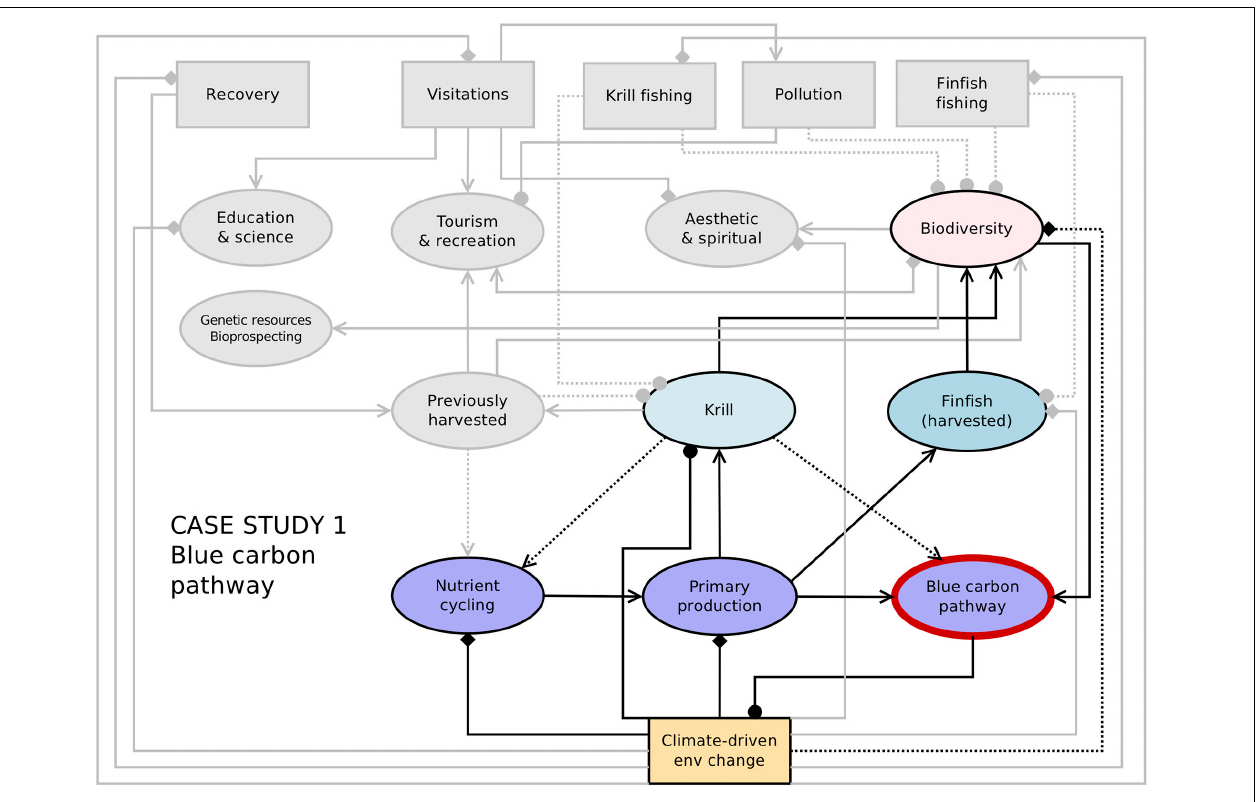
FIGURE 3 | Network representation of the links and feedbacks between ecosystem services and drivers (from Figure 2 ) with key elements for the blue carbon pathway highlighted. Connections between components indicate the direction of effects from one node to another, as indicated in the legend. Diamonds indicate cases where the direction of the effect is not known or unclear (i.e., it could be positive and/or negative), and dashed lines represent uncertain or weak